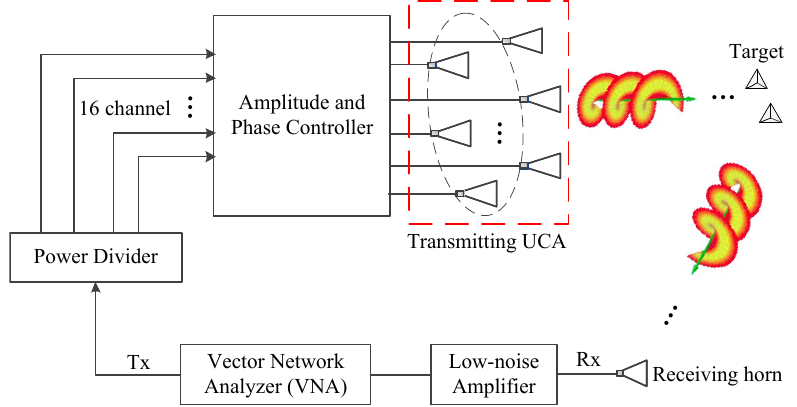
Figure 5. Block diagram of EM vortex imaging system. UCA: uniform circular array.